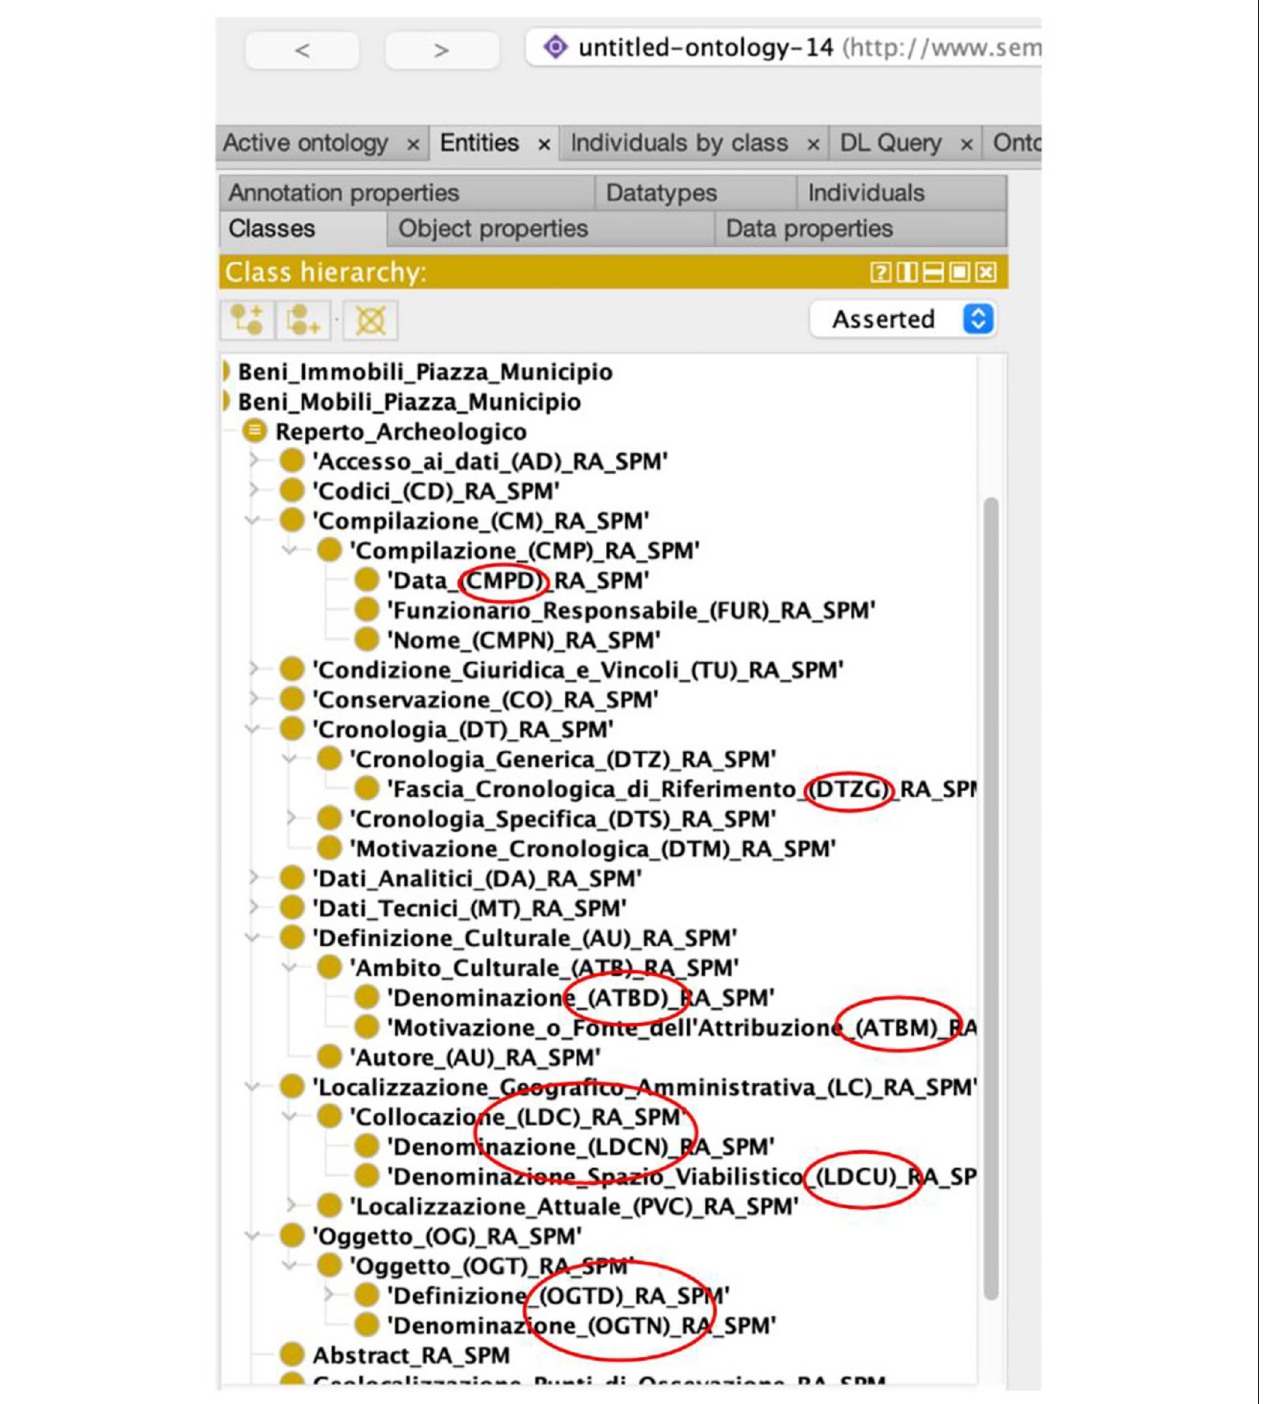
FIGURE 4 | A detail of the PAUN ontology mapping the RA “Archaeological Find” record. We circled in red the nodes of the ontology not found in ArCo.